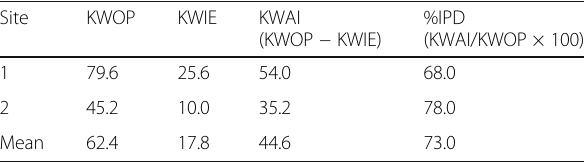
Table 2 Insect pollinator dependency of shea kernel yield (kg) in the Guinea savanna zone of Ghana Site